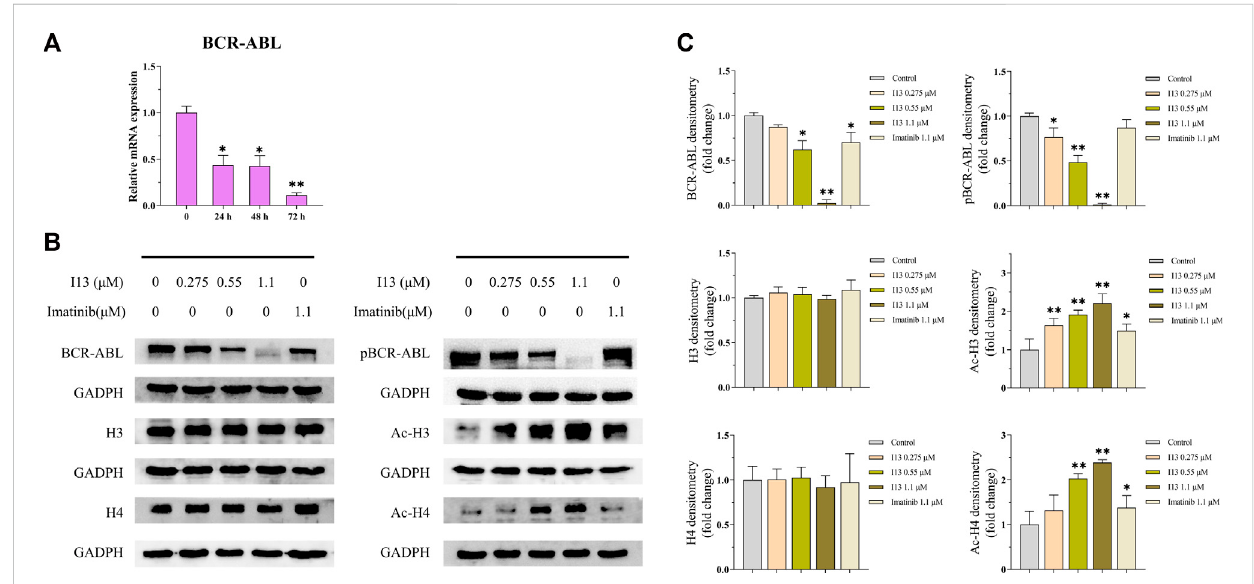
The effects of I13 on the mRNA and protein expression levels of differentiation-related genes in BaF3-T315I cells. (A) Quantitative real-time PCR analysis of mRNA expression level of BCR-ABL. The cells were exposed to 1.1 µM of I13 for 24, 48, or 72 h. (B) Immunoblotting analysis of BCR-ABL, p-BCR-ABL,H3,Ac-H3, H4,andAc-H4. (C) The bargraph shows theintensity of theproteinbandquanti fi edbyAI600 images.The cells wereexposedto 0.275, 0.55, and 1.1 µM of I13 or 1.1 µM of imatinib for 72 h (* p < 0.05, ** p <